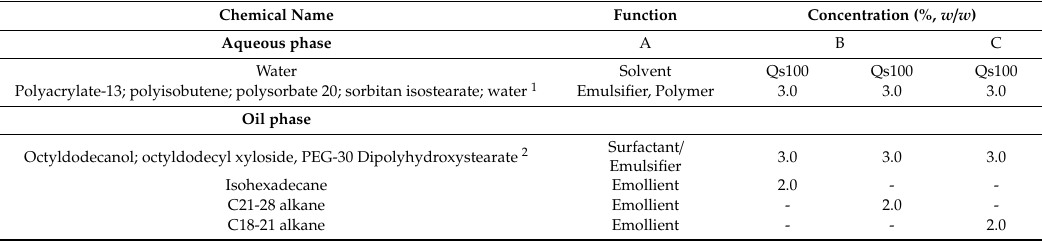
Table 1. Quantitative and qualitative composition of gel-in-oil emulsions A, B and